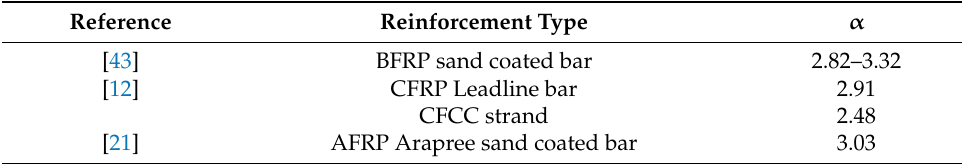
Table 2. Summary of the bond shape factor α .